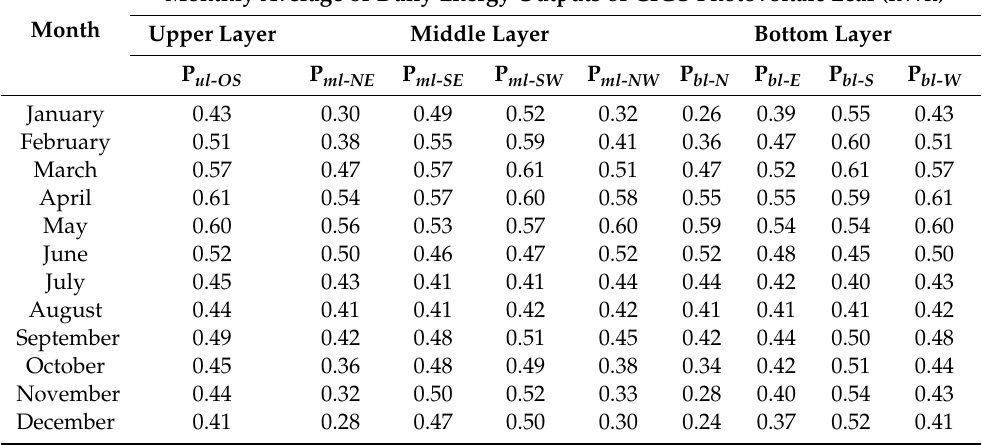
Table 6. Monthly average of daily energy outputs of CIGS photovoltaic leaves in the three di ff erent layers of the solar photovoltaic